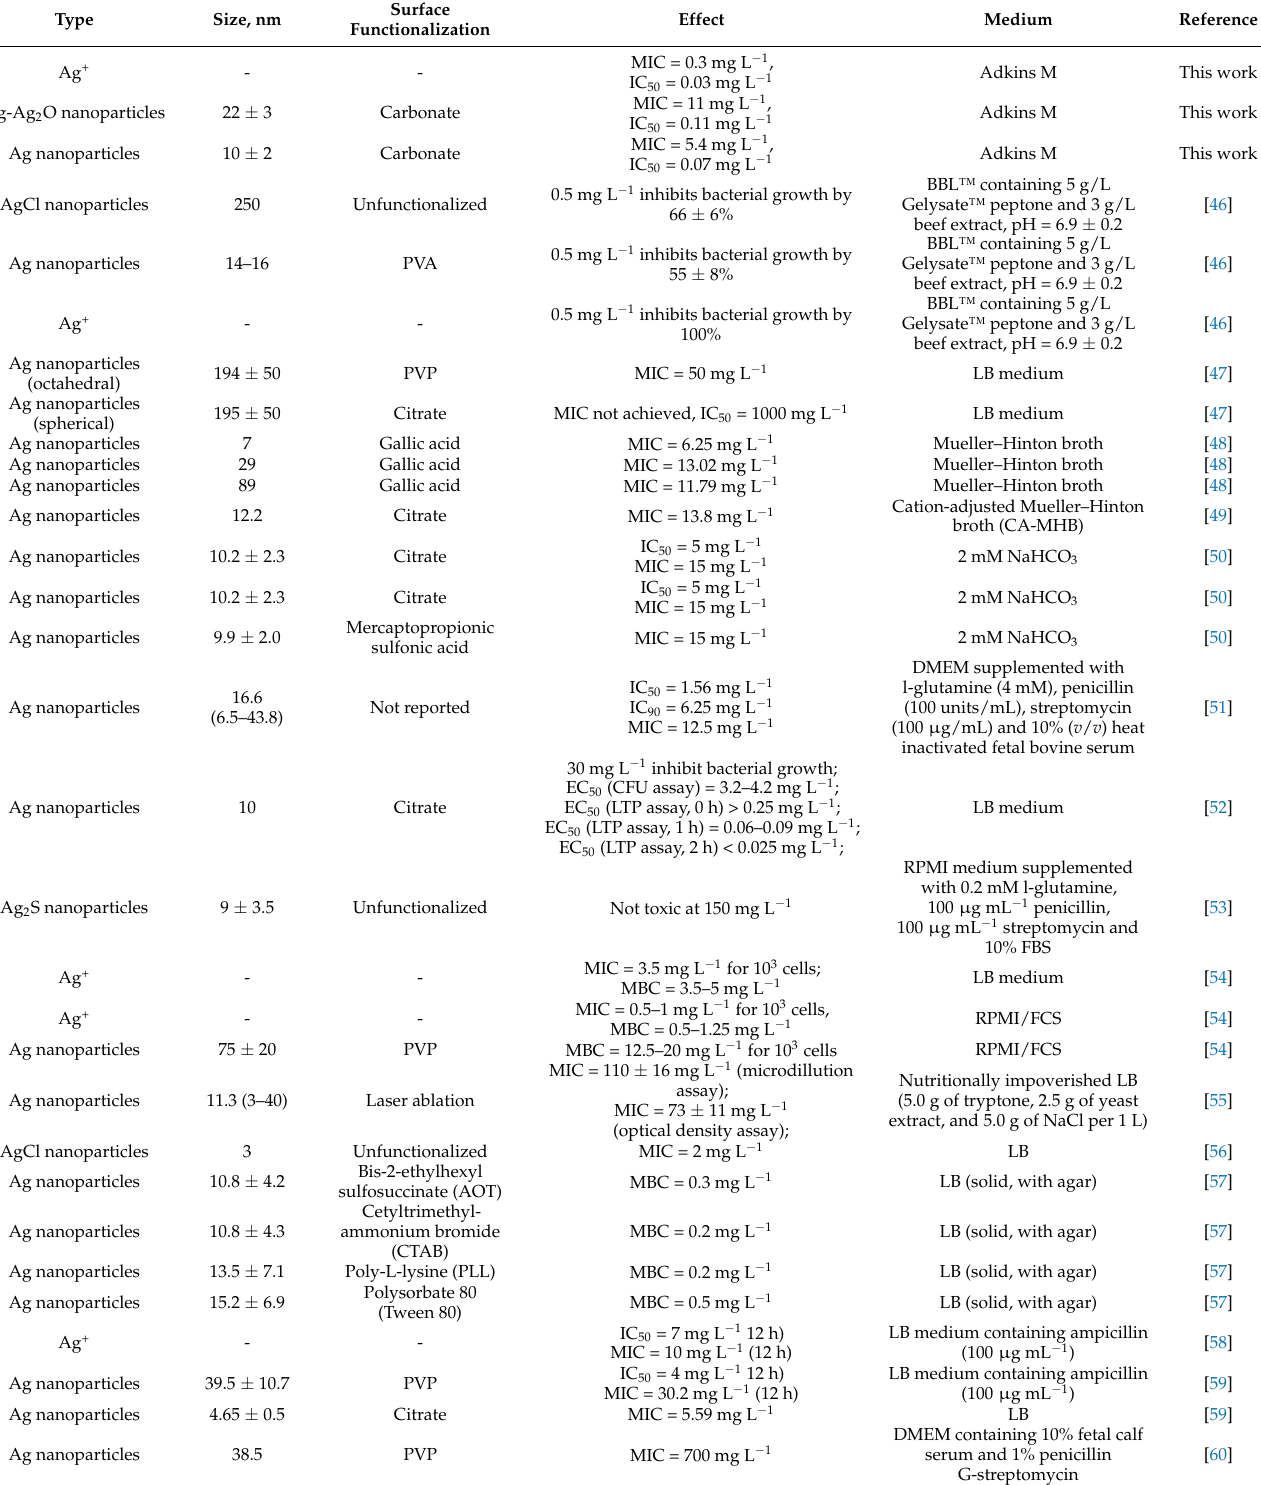
Table 2. Antibacterial characteristics of Ag + and nanoparticles against Escherichia coli